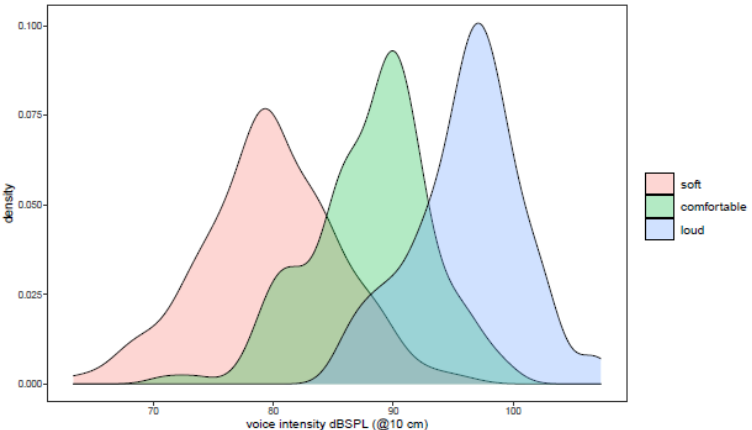
Figure 2. Sound pressure level (SPL) distribution (@10 cm) in “soft”, “comfortable”, and “loud” phonations of 58 women with voice disorders and 58 age-matched, vocally healthy controls. The area under each curve indicates the probability (termed density) that a value will fall within the indicated interval. (Figure: own image, derived from [42,43]).